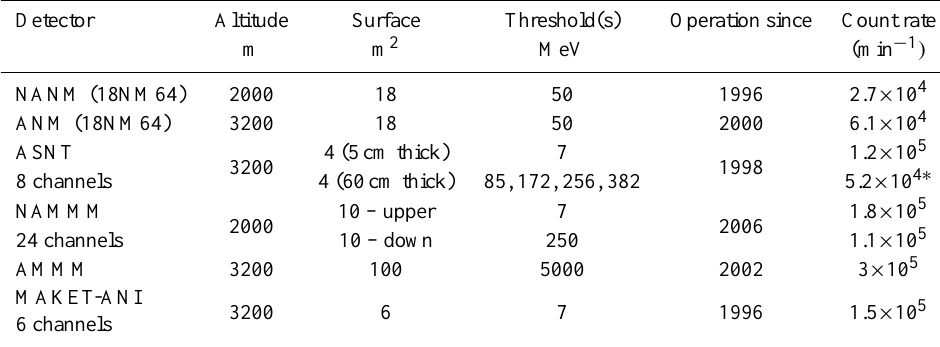
Table 1. Characteristics of ASEC